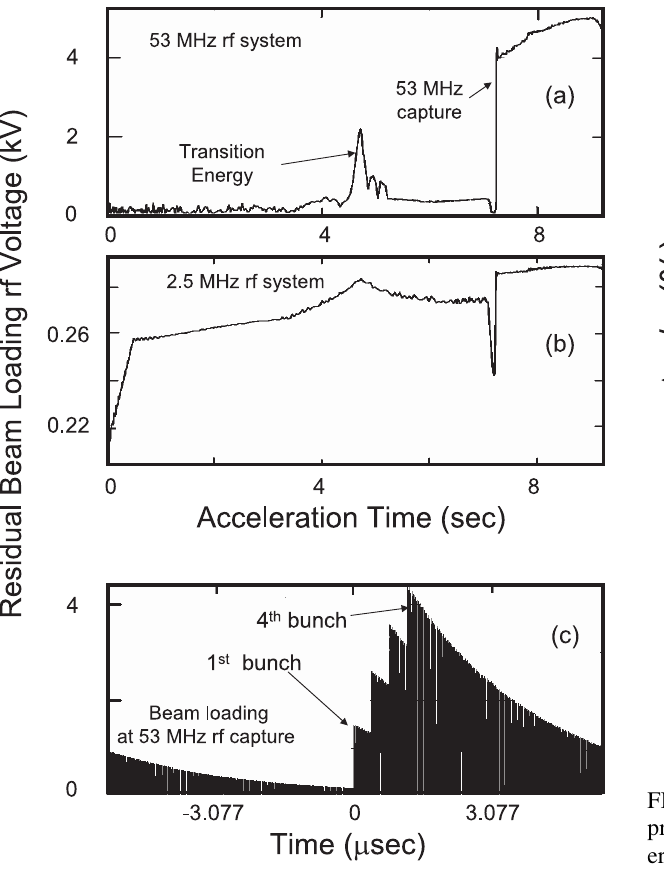
FIG. 4. Predicted residual beam-loading voltage for four bunches with 17 (cid:7) 10 10 particles = bunch for (a) 53 MHz rf cavities, (b) 2.5 MHz rf cavities for the duration of beam acceleration from 9 to 150 GeV. The 9–150 GeV acceleration time was about 9.3 sec. (c) Instantaneous 53 MHz residual beam- loading voltage at its maximum during harmonic transfer. The simulations are carried out with 2.5 and 53 MHz rf cavity BLC which include both feedback and feed-forward BLCs as ex- plained in the text and Table I. The transition time and the time of transfer between rf systems are also indicated on (a). The steps in (c) correspond to the passing of each bunch. The " this case was 1.3 (95%) eV s.